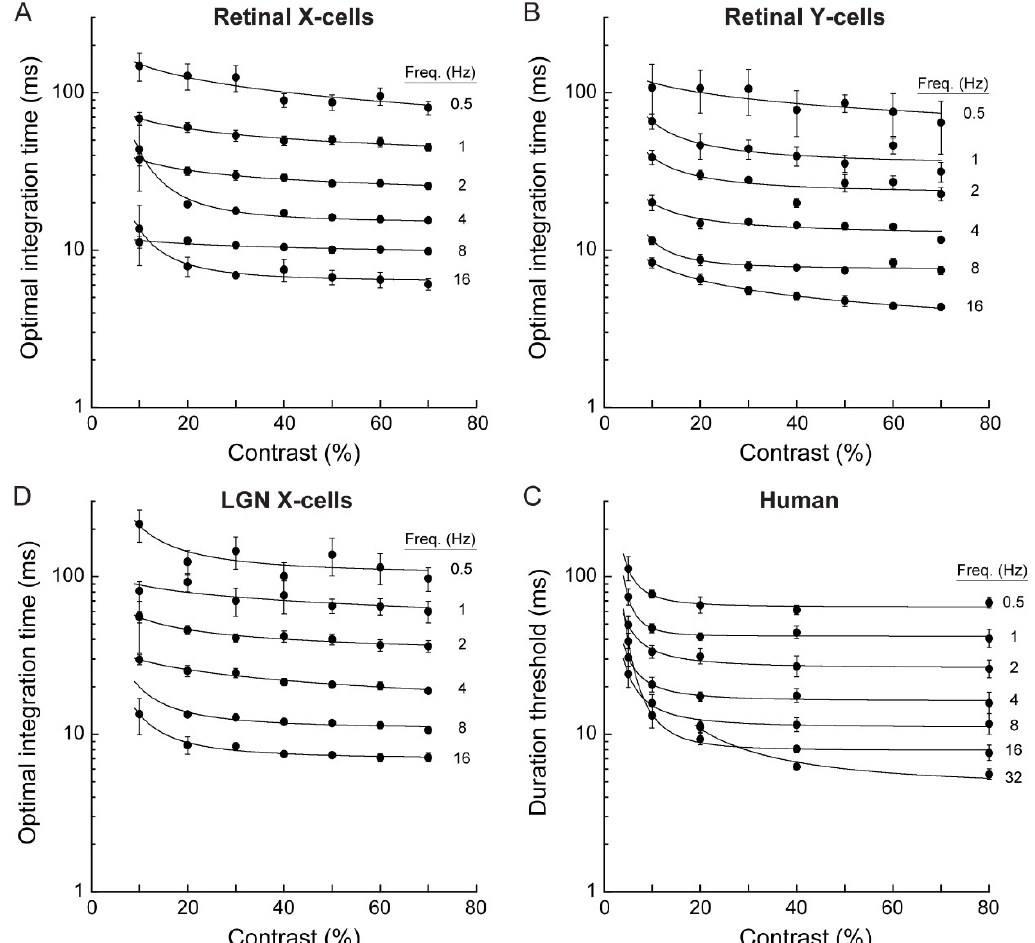
Figure 4. Optimal integration times and duration thresholds decreased with increasing temporal frequency but changed little with contrast. ( A–C ) Optimal integration times for all combinations of stimulus temporal frequency and contrast for 33 retinal X cells, 4 retinal Y cells, and 20 LGN X cells. Optimal integration time systematically decreased with increasing temporal frequency, but was largely independent of contrast above about 10%. Error bars show mean ± SEM. ( D ) Minimal presentation duration required for human observers to discriminate motion direction as a function of stimulus temporal frequency and contrast. The duration threshold decreased with temporal frequency of the sinewave grating. Above about 10%, the duration threshold was largely independent of stimulus contrast. Error bars show mean ± SEM for four subjects.